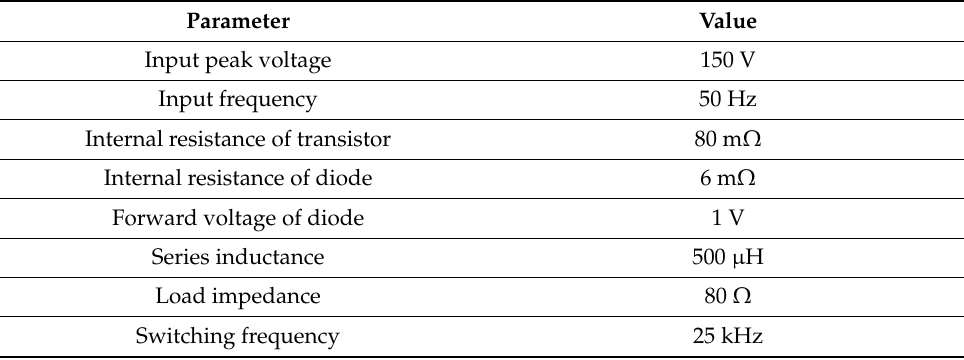
Table 3. Parameters employed for simulation